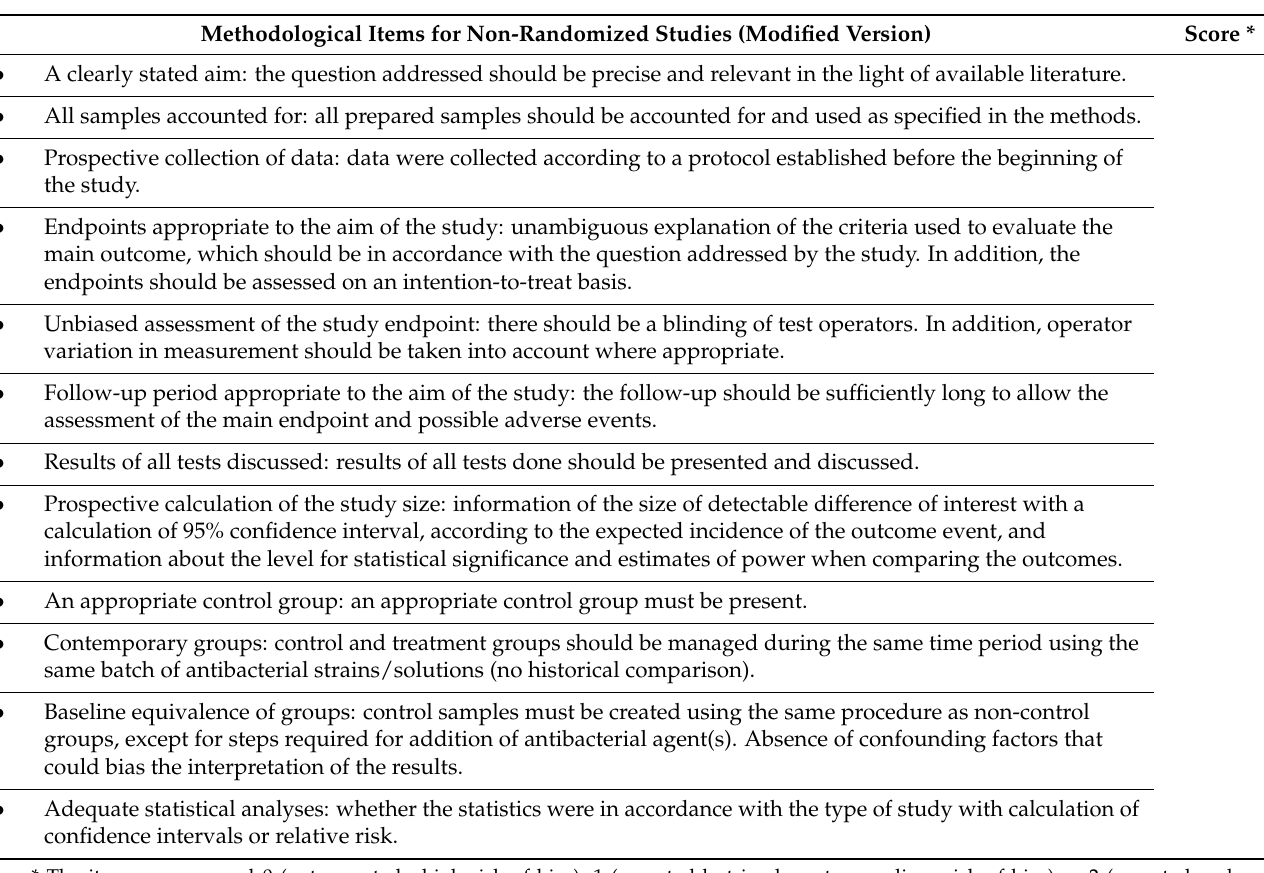
Table 2. Modified Methodological Index for Non-Randomized Studies (MINORS) tool. Methodological Items for Non-Randomized Studies (Modified